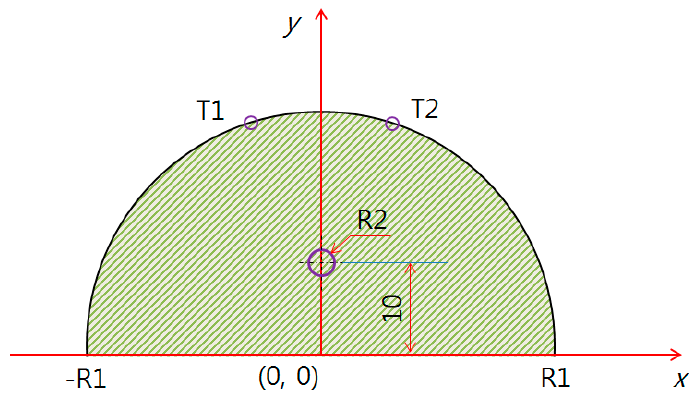
Figure 4. Defect position along the diagonal direction (X = 10, Y = 10).